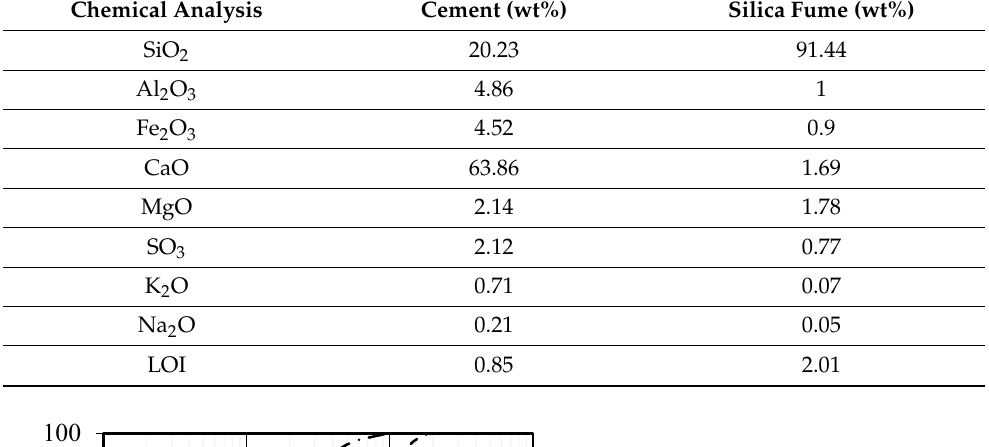
Table 2. Chemical composition of cement and silica fume. Table 3. Properties of superplasticizer.